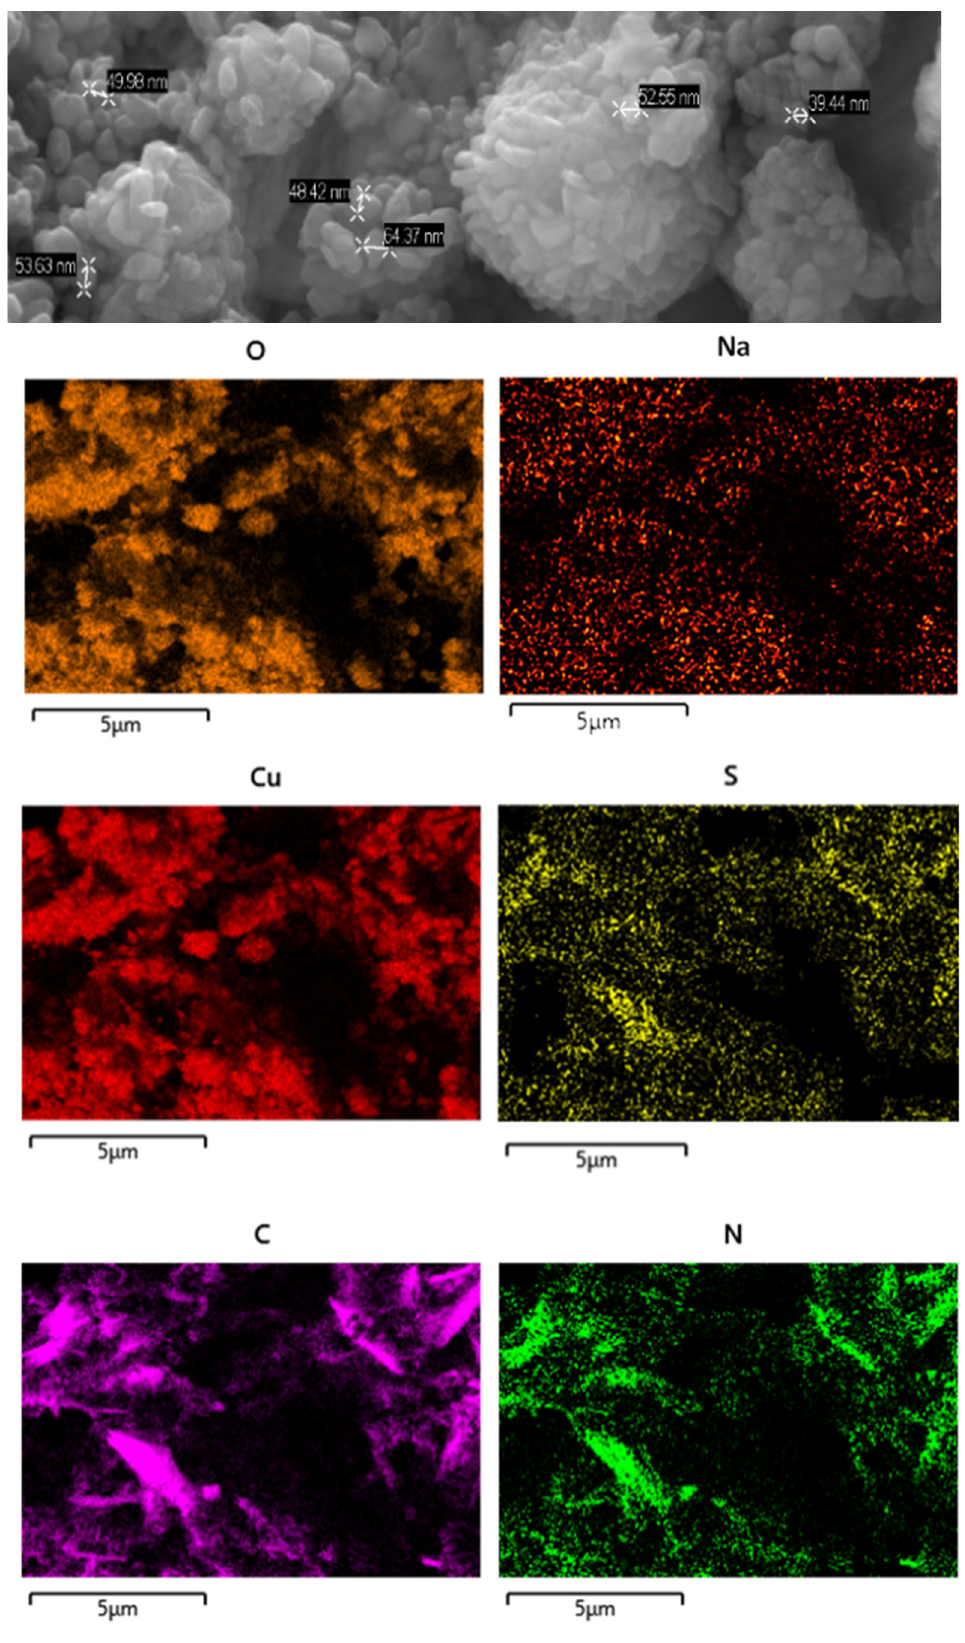
Figure 11. ( Top ): SEM micrograph of H 3 L-CuO NPs. ( Bottom ): EDX mapping pattern of the element distribution: Cu, O, S, N, C, and Na.